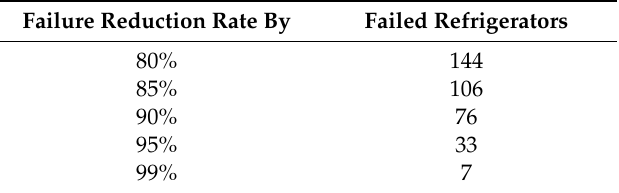
Table 4. Number of failed refrigerators corresponding to di ff erent failure rates.